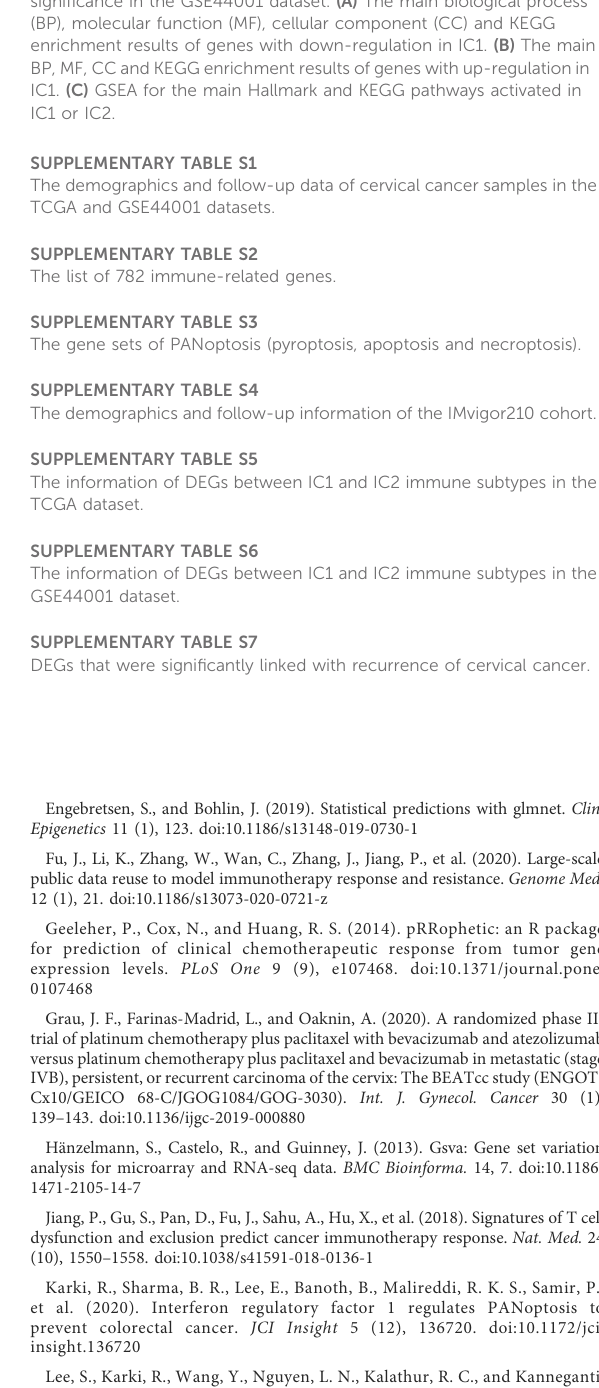
SUPPLEMENTARY FIGURE S3 Validation of immune subtypes-relevant genes and their biological signi fi cance in the GSE44001 dataset. (A) The main biological process (BP), molecular function (MF), cellular component (CC) and KEGG enrichment results of genes with down-regulation in IC1. (B) The main BP, MF, CC and KEGG enrichment results of genes with up-regulation in